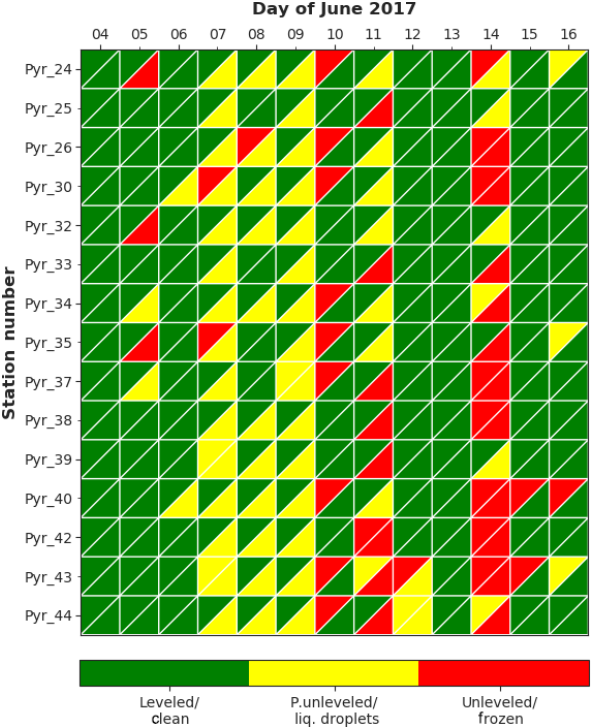
Figure 2. Quality flags for the pyranometer sensors: the pyranome- ter station number is shown on the y axis, and date is shown on the x axis. Each square is divided into two triangles: the upper shows the leveling flag and the lower the cleanliness status. Green is used for well-leveled and clean stations, yellow denotes partially unleveled stations or the presence of liquid droplets on the domes, and red is used for unleveled stations or iced